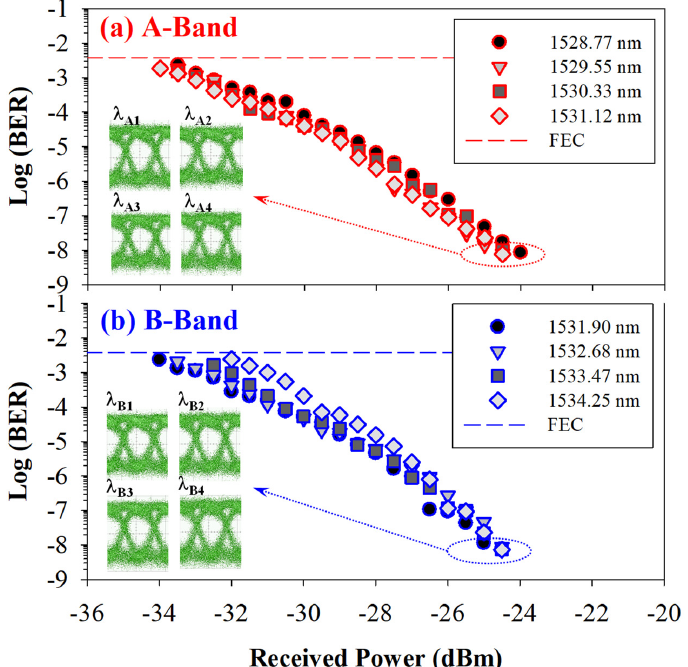
Figure 4. Measured 24.3 Gbit/s BER behaviors of ( a ) λ A1D to λ A4U and ( b ) λ B1D to λ B4U at the BtB status, respectively. Insets are the measured eye diagrams of eight wavelengths at the received powers of − 24.0 to − 24.5 dBm, respectively.